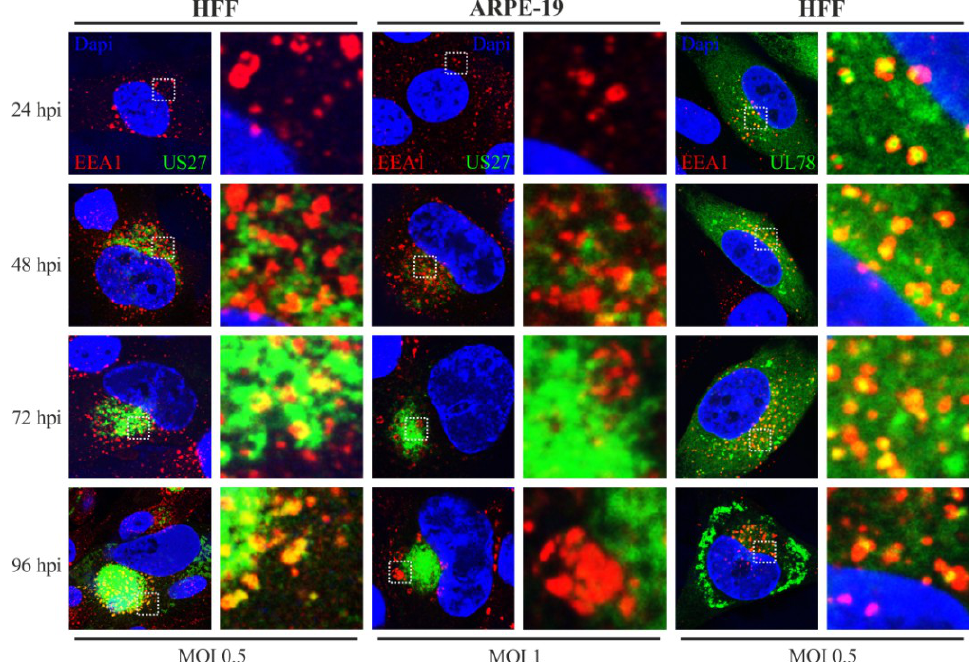
Figure 5. EEA1 staining of US27-EYFP and UL78-EYFP infected HFFs and ARPE-19 cells. HFF (left and right panel) or ARPE-19 cells (middle panel) were infected with recombinant TB40/E viruses (MOI: 0.5 or 1) expressing fusion proteins of pUS27 (left and middle panel) or pUL78 (right panel) with EYFP and fixed at different time points during HCMV infection (24–96 hpi). Cells were stained with primary antibody pAb-EEA1 (H-300), diluted 1:200, and the secondary anti-rabbit antibody coupled to Alexa-555 (1:400). Cell nuclei were stained with